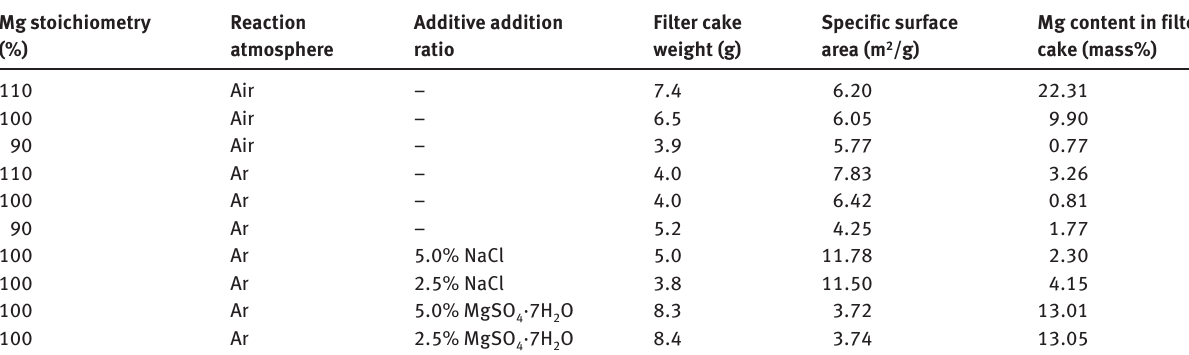
Table 2: Specific surface area values and Mg contents of leached TiB 2 SHS products Mg stoichiometry